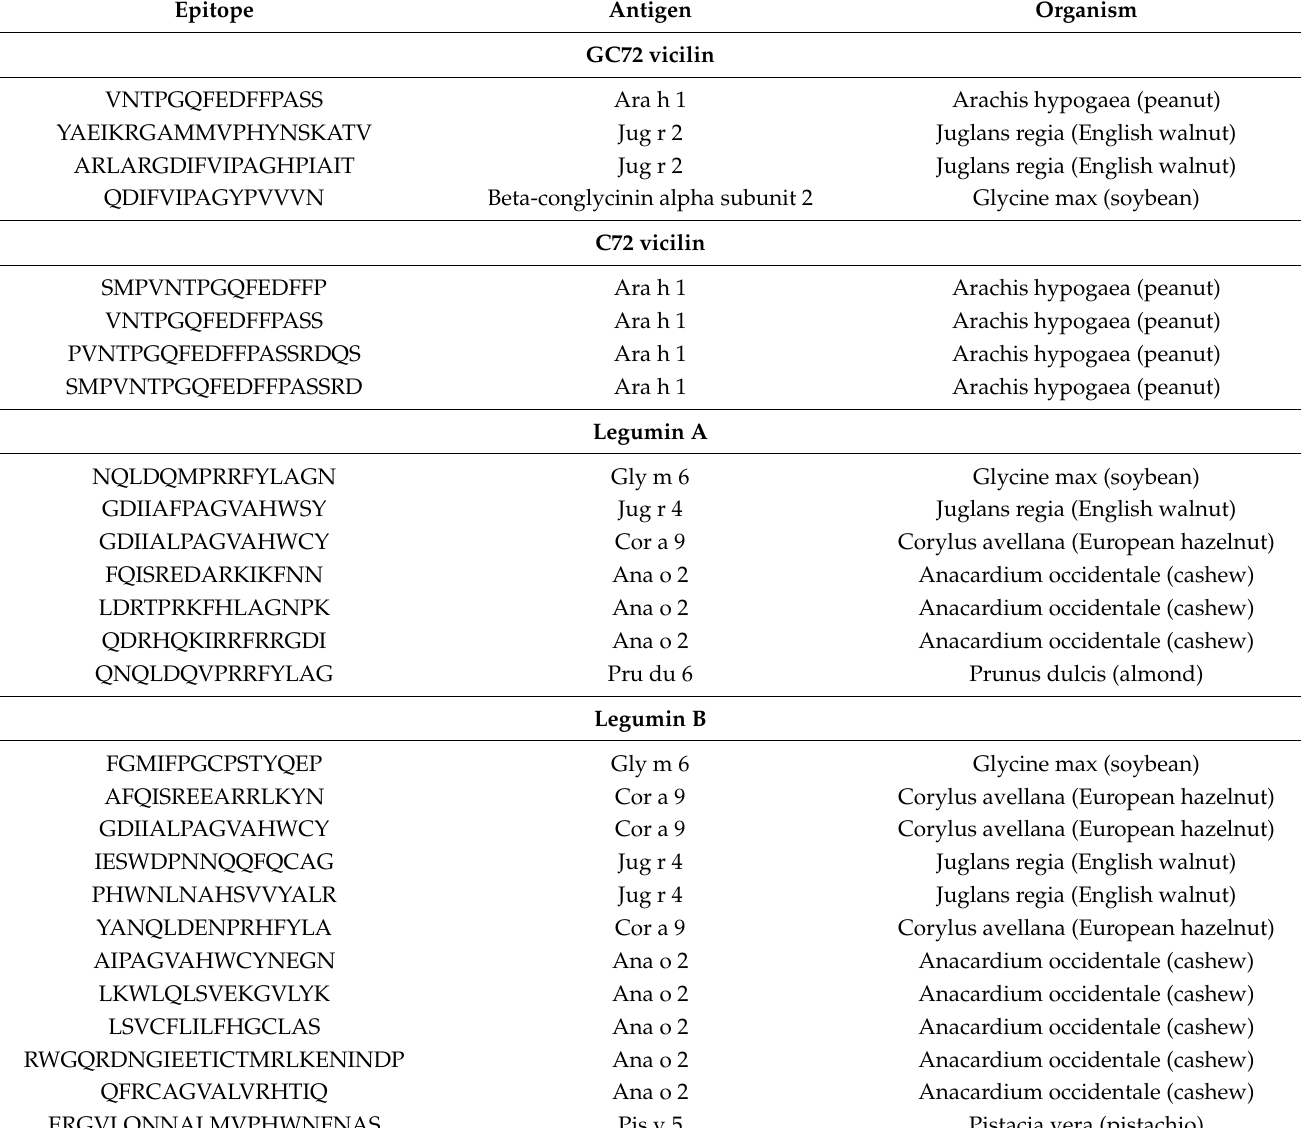
Table 5. Cotton Vicilin and Legumin Peptide Sequences 70% Similar to Peanut and Tree Nut IgE